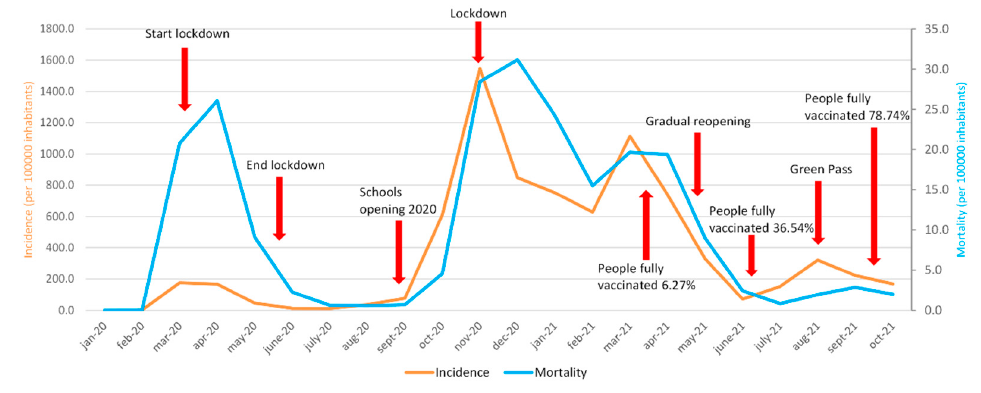
Figure 8. Some measures adopted by the Italian government during pandemic.